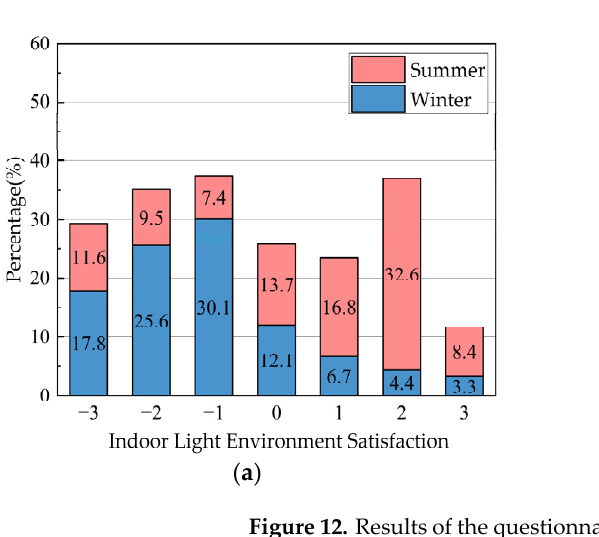
Table 4. Reflection ratio of interior finishes.